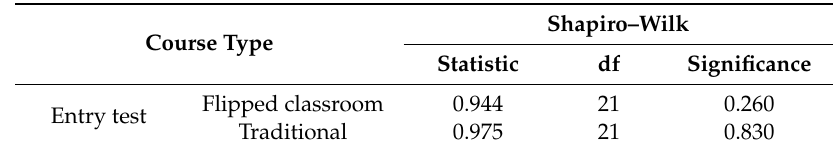
Table 4. Entry test—Shapiro–Wilk test results.